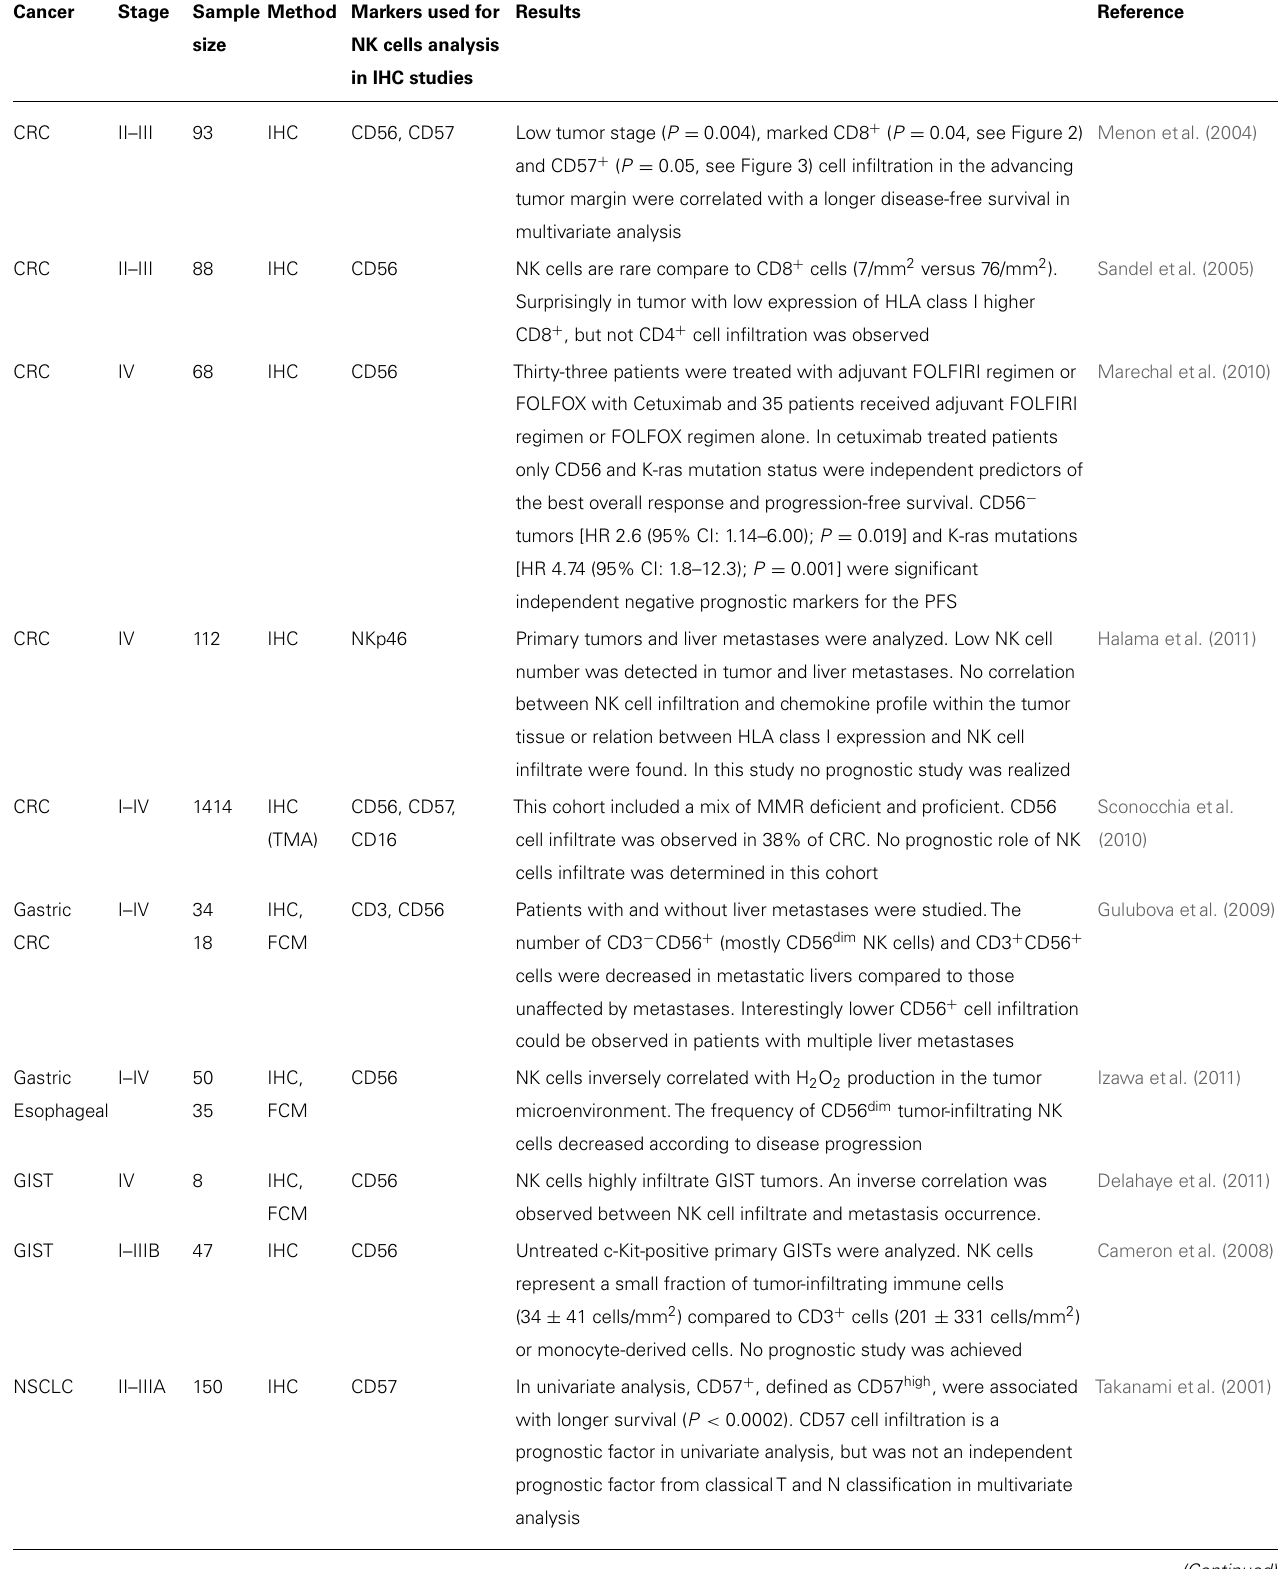
Table 1 |Tumor infiltrating NK cells in human